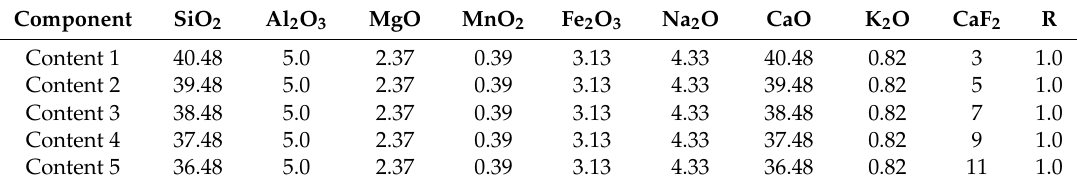
Table 1. Chemical composition of a fluorine-containing mold flux